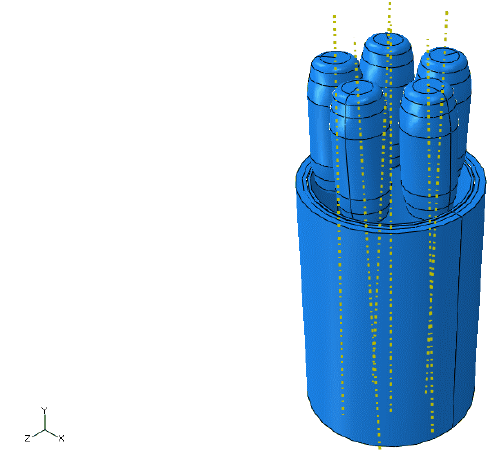
Figure 1: 3D model of bimetallic clad pipe formed by